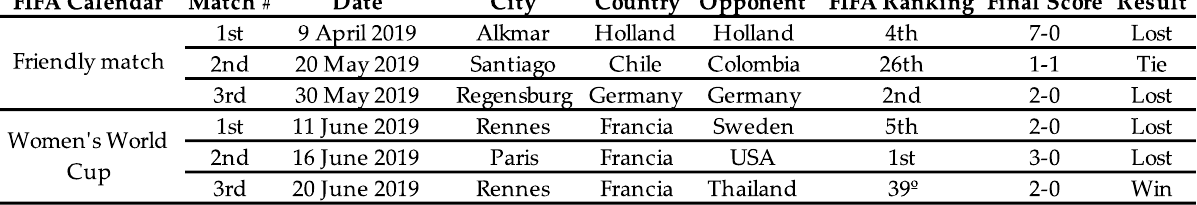
Figure 1. Official calendar of FIFA Friendly Matches and the Women’s World Cup in France 2019 analyzed for the study .